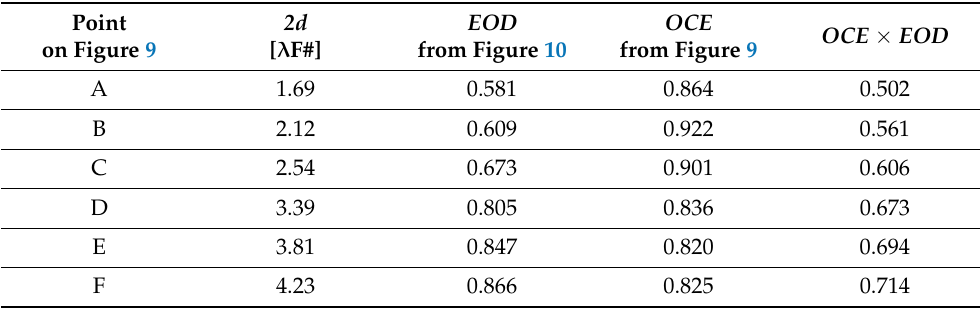
Table 1. The EOD , the OCE, and their product for small and medium pixel sizes and a circular aperture with a rectangular